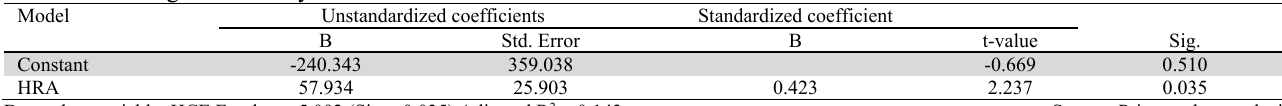
The results of regression analysis